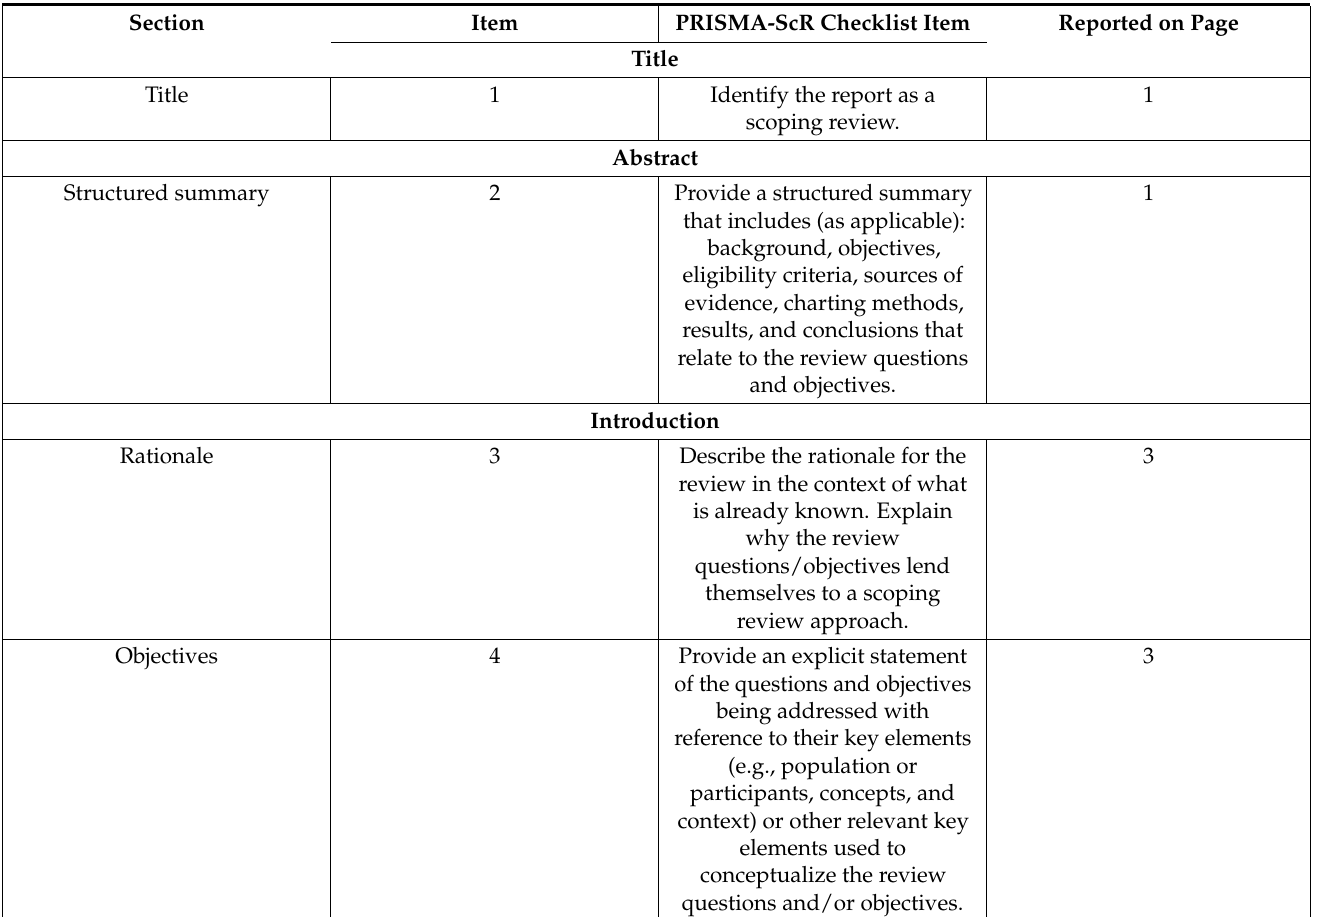
Table A1. Preferred Reporting Items for Systematic reviews and Meta-Analyses extension for Scoping Reviews (PRISMA-ScR)